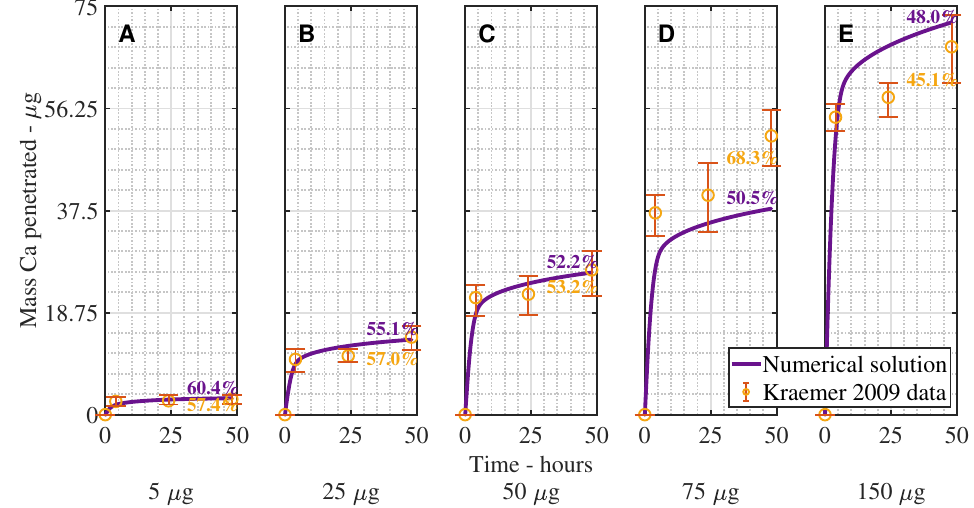
Figure 4. Numerical solution (purple line) of the model compared to experimental data (orange circles) for CaCl with RSO 5, using an initial applied mass of Ca of 5 µ g ( A ), 25 µ g ( B ), 50 µ g ( C ), 75 µ g ( D ), 2 150 µ g ( E ) with RSO 5 (1 g/L) over 48 h. The mass of Ca penetrated in µ g is compared to time in hours, calculated according to Equation (24). The numerical solution can be seen as the continuous purple line and the experimental data as orange circles with error bars. The final percent Ca penetration is shown on each subfigure at 48